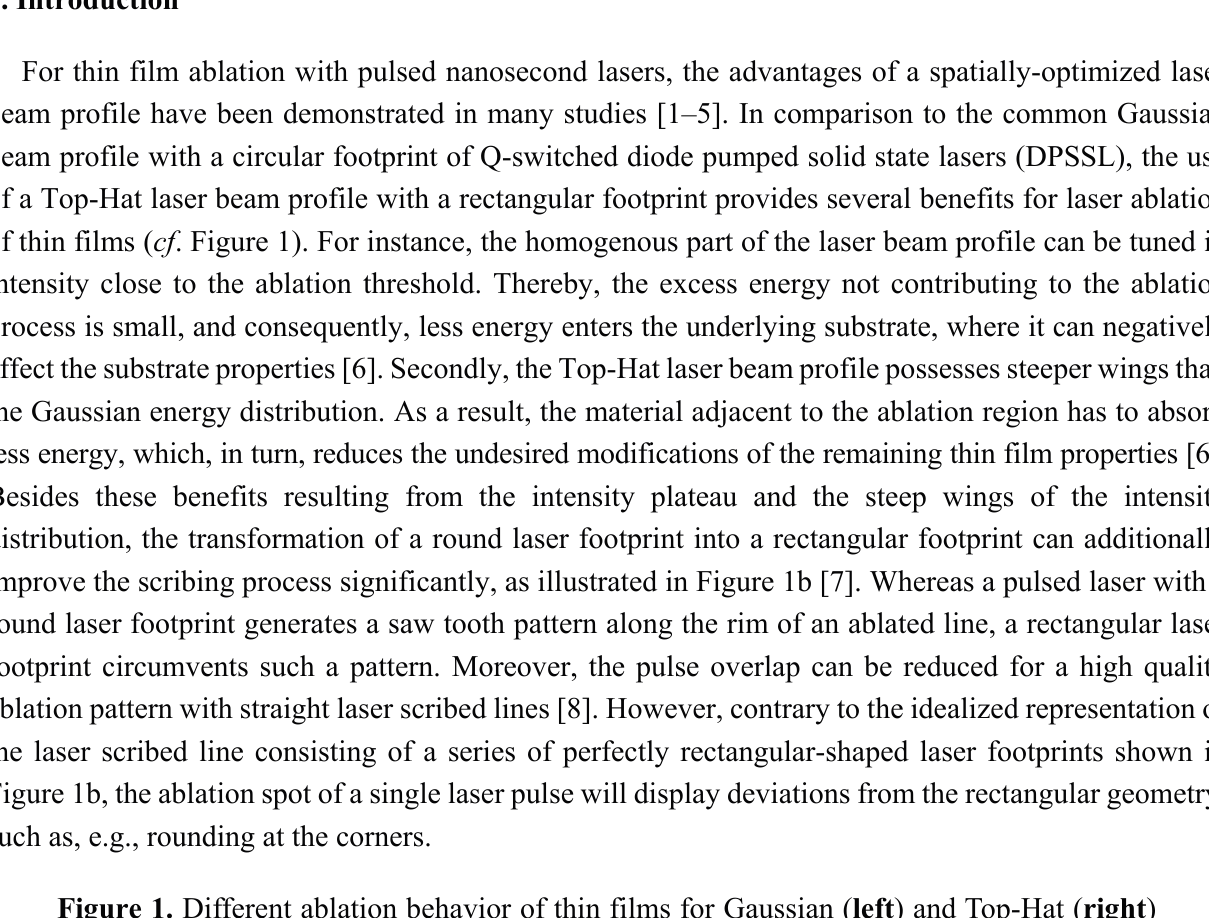
Figure 1. Different ablation behavior of thin films for Gaussian ( left ) and Top-Hat ( right ) laser beam profiles. ( a ) Cross-section of laser beam profiles; ( b ) ablated line with circular and rectangular laser footprint; ( c ) cross section of the processed material system with implied heat affected zone (HAZ)